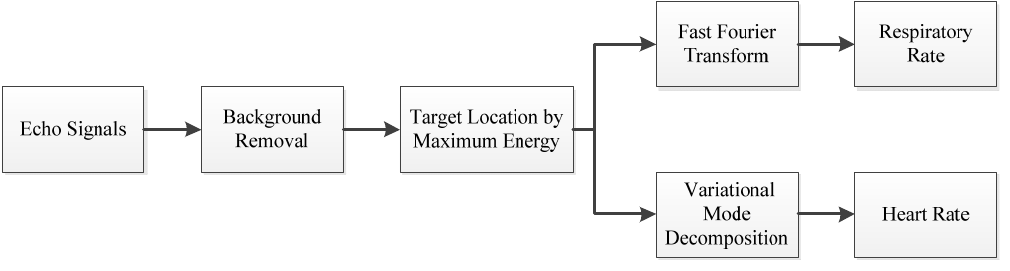
Figure 1. Flow diagram of radar signal processing.